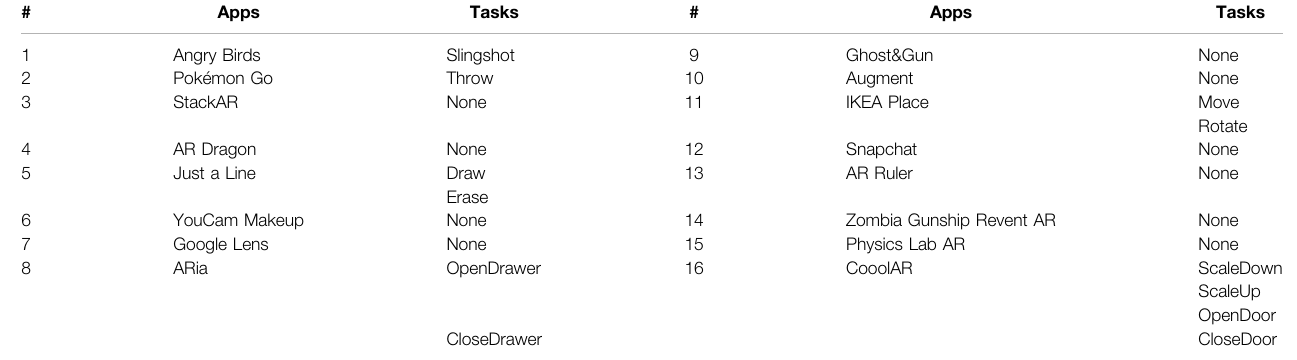
TABLE 1 | A list of selected tasks from 16 common mobile AR applications.